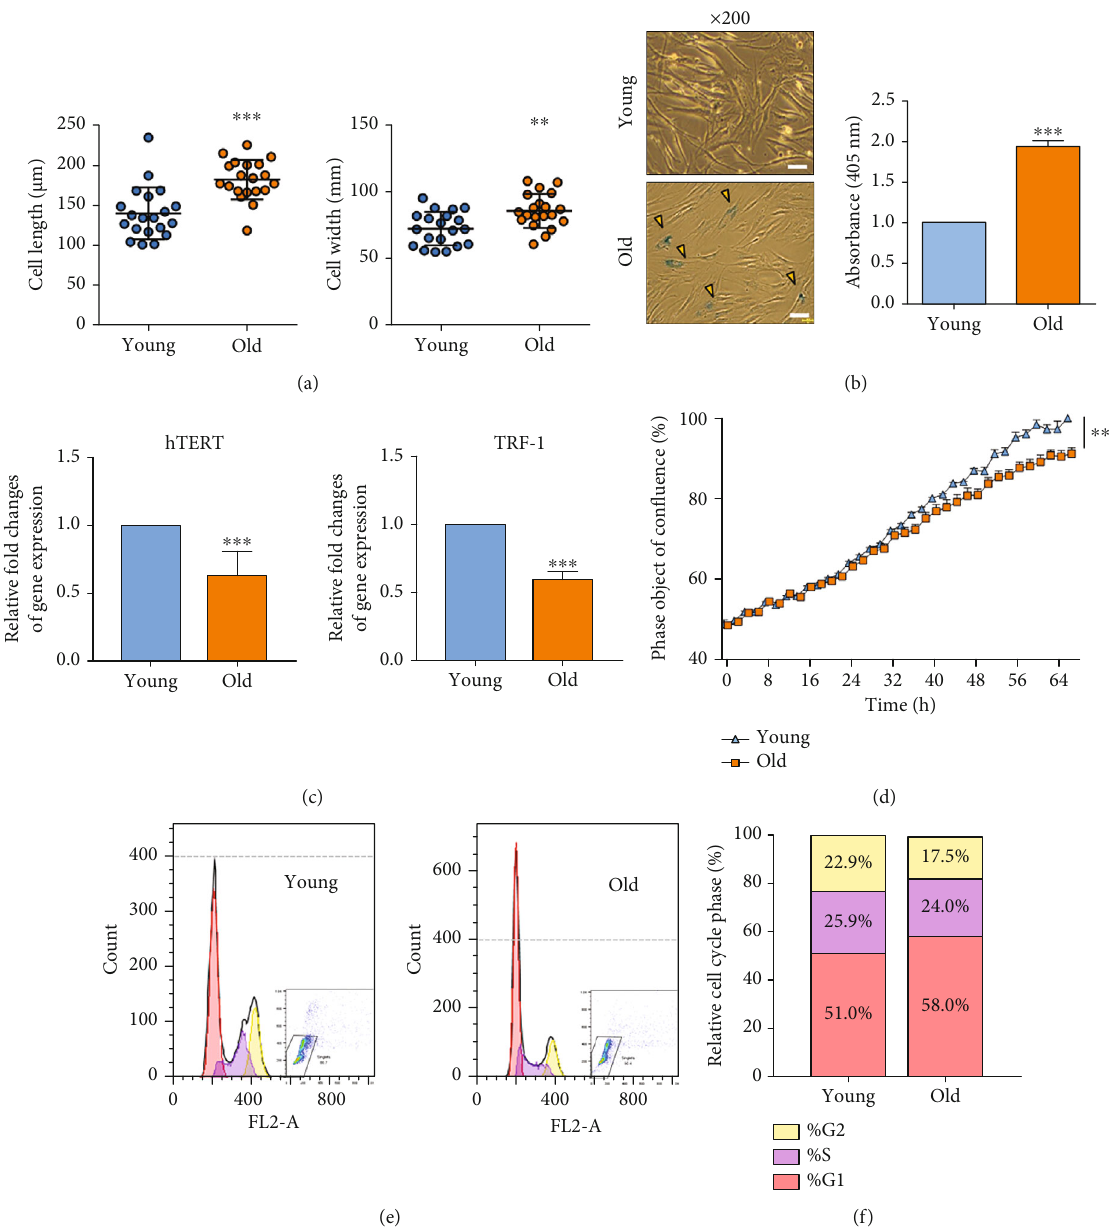
Figure 1: Changes in senescent markers with serial passaging of TMSCs. (a) Morphological changes of young and old TMSC groups were determined by measuring cell length and width. Young TMSCs exhibited a polygonal morphology, whereas old TMSCs formed dispersed shapes. (b) Senescent cells were identi fi ed as blue-stained cells under an optical microscope. Magni fi cation: × 200; scale bar, 50 μ m. The orange arrowhead indicates stained cells. Senescent cells were identi fi ed as blue-stained cells and were calculated by the average absorbance intensity of SA- β -gal staining (405nm) from 5 randomly selected fi elds between young and old TMSCs. (c) Gene expression of hTERT and TRF-1 which are telomere length markers in TMSCs. (d) Cell proliferation pro fi le of young and old TMSCs during 64 h. The blue triangle line indicates young TMSCs, and the orange rectangle line indicates old TMSCs. (e, f) The TMSCs from each experimental group were stained with PI staining solution and analyzed their cell cycle stage. The p values were considered statistically signi fi cant at ∗∗ p < 0 : 01 and ∗∗∗ p < 0 : 001